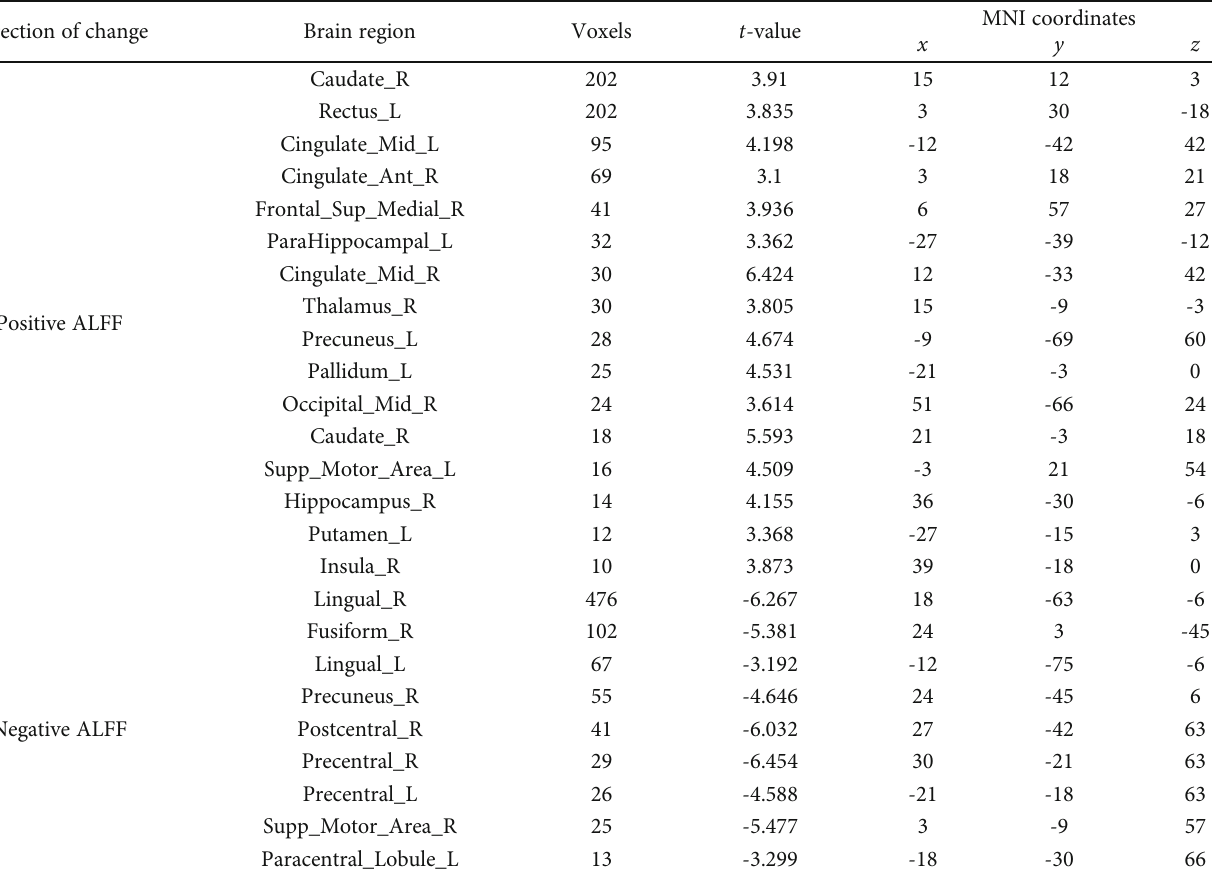
Table 4: Relative regional changes in ALFFs at 12 months.